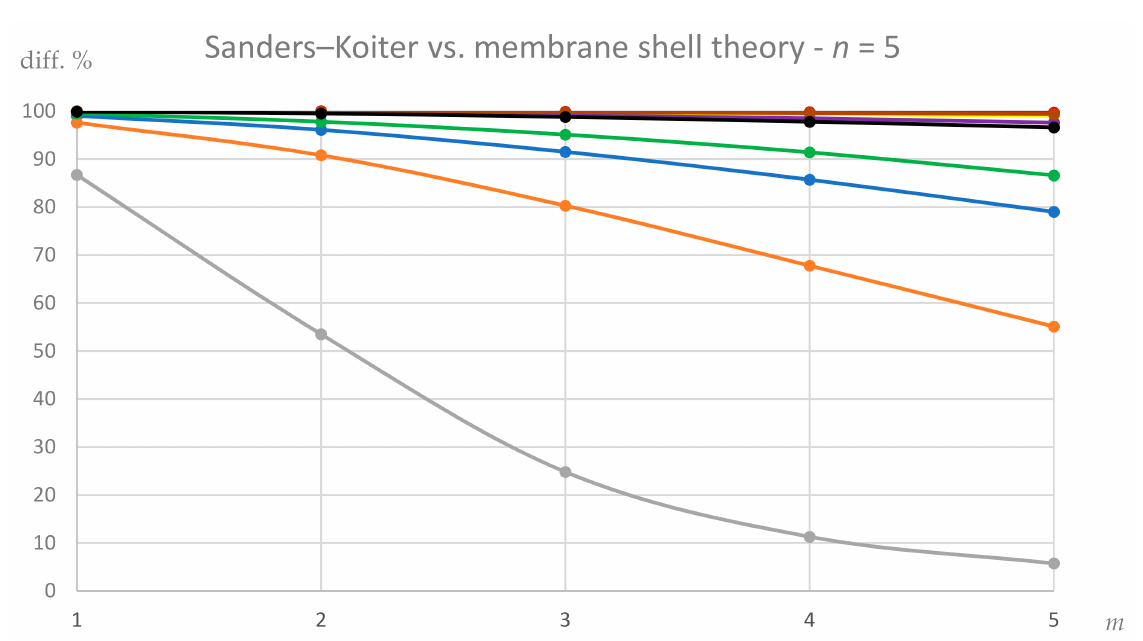
Figure 5. Simply supported DWCNT of Table 1 with different values of aspect ratio L / R 2 and thickness ratio R 2 / h . Shell- like modes ( n = 5). Comparisons between extended Sanders–Koiter and simplified membrane shell theories,